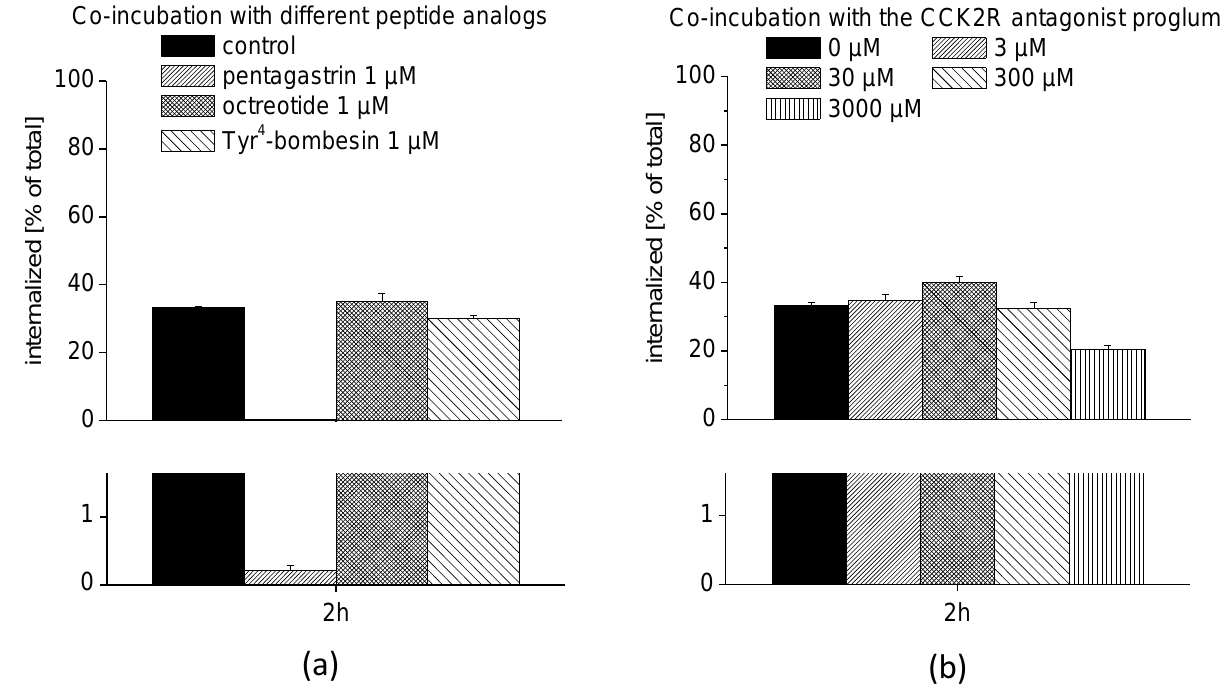
Figure 6. Cell uptake studies with 68 Ga-DOTA-MGS5 on AR42J cells: ( a ) Co-incubation with different peptide analogs specific for CCK2R, SSTR, and GRPR; ( b ) co-incubation with increasing concentrations of the CCK2R antagonist